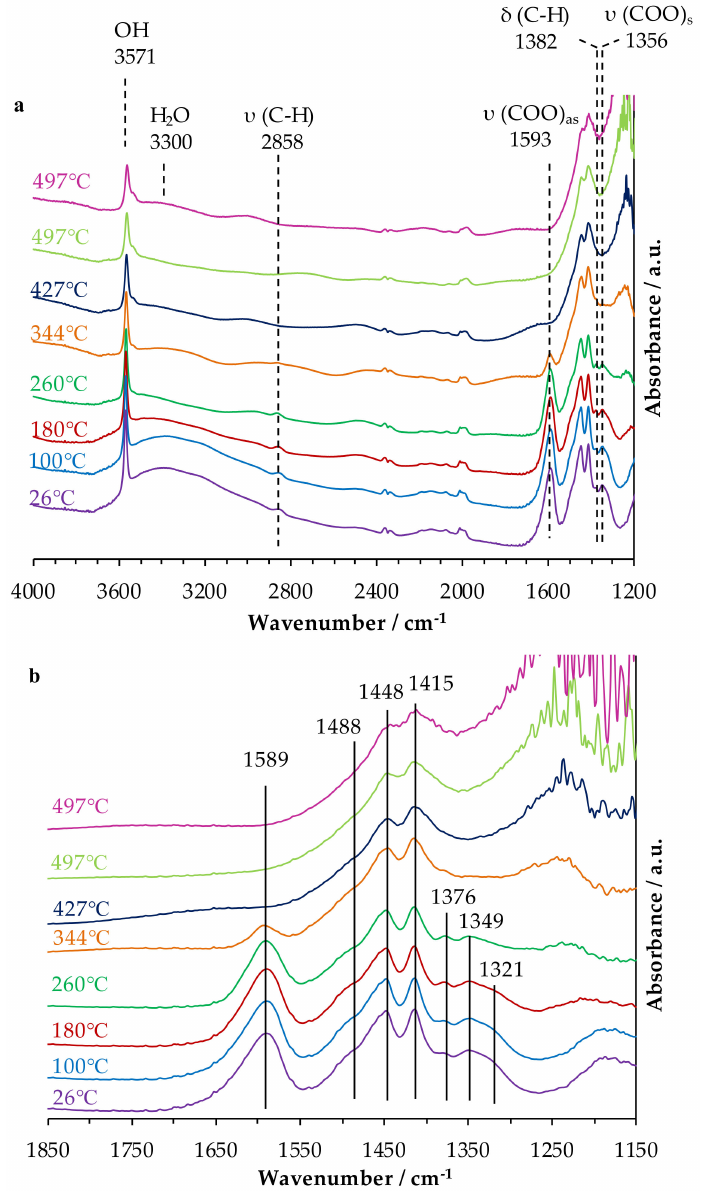
Figure 11. IR spectra of the Mn10HapF sample after HCHO adsorption and heating under He ( a ) in the 1200–4000 cm − 1 and ( b ) 1150–1850 cm − 1